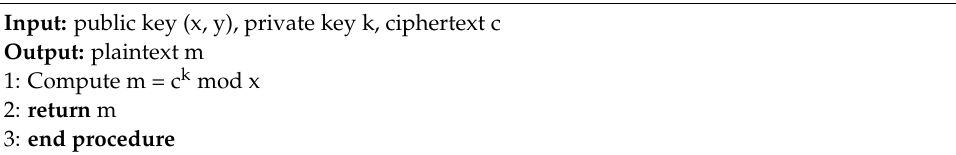
Algorithm 5 RSA decryption algorithm